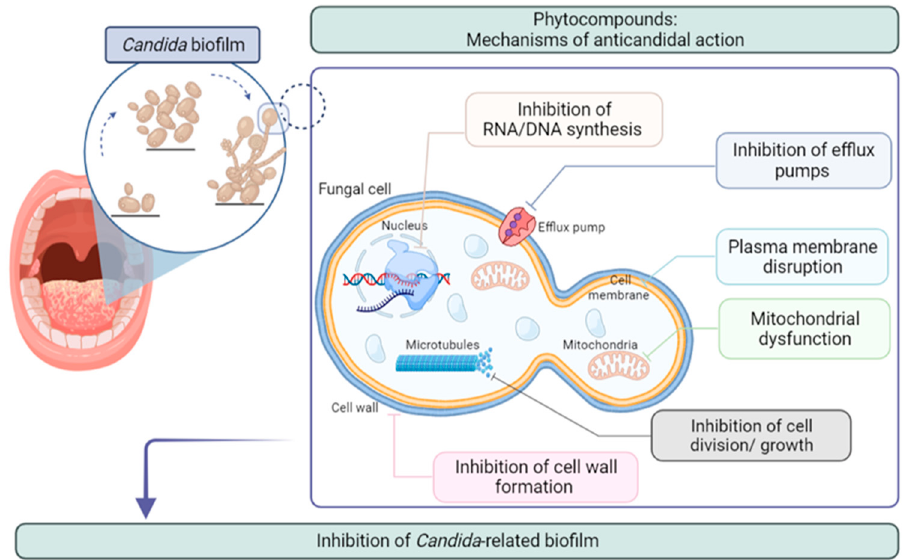
Figure 1. Mechanisms of action of phytocompounds against Candida spp. (Created with BioRender.com).